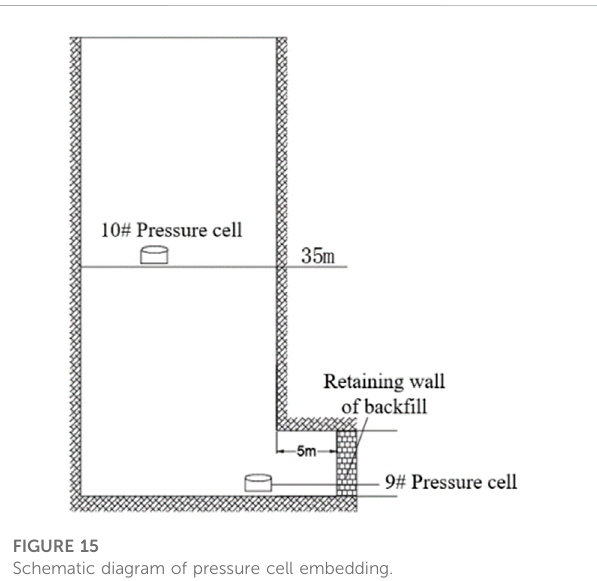
FIGURE 15 Schematic diagram of pressure cell